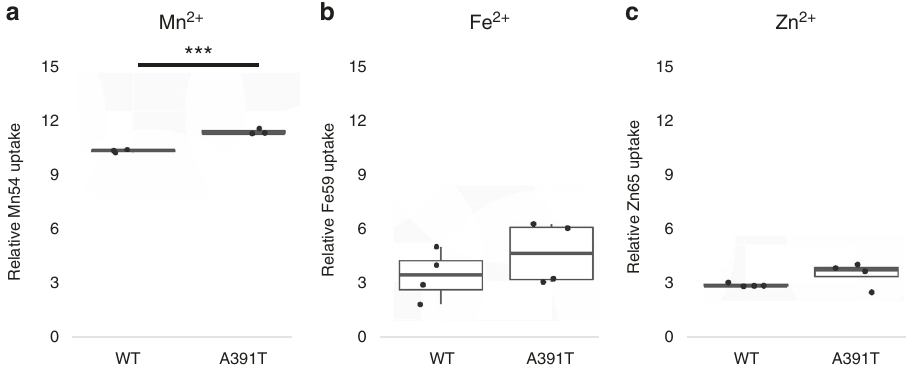
Fig. 3 Cellular uptake of ions with SLC39A8 overexpression in HEK293 cells. Comparison of uptake of either radio-labeled a Mn 2 + , b Fe 2 + , or c Zn 2 + with overexpression of either vector control, SLC39A8 wild-type or SLC39A8 A391T in HEK293 cells. All measurements were the average of three replicate experiments. Lines are median, 1st and 3rd quartiles. Error bars are 95% con fi dence intervals. All comparisons were performed using t -tests. *** P = 5 × 10 − 4